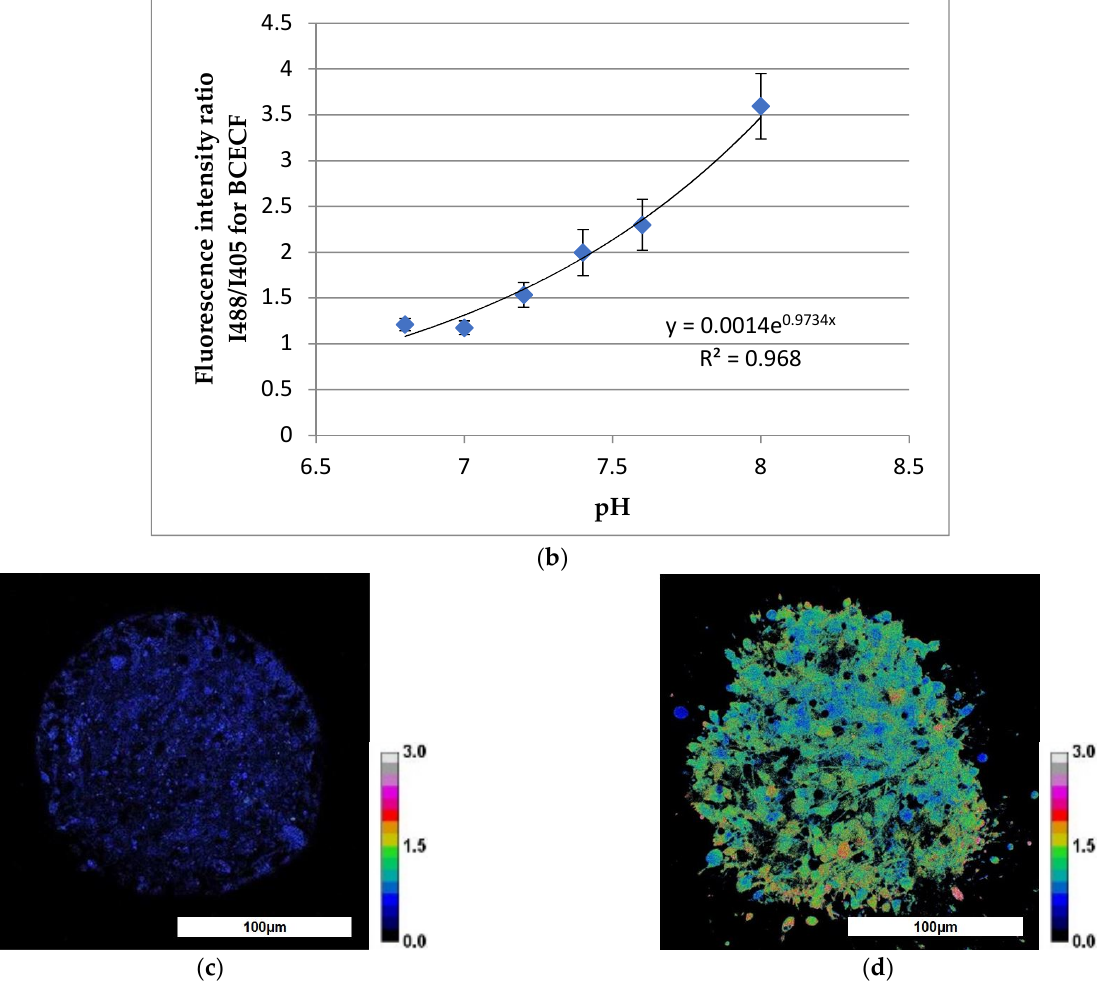
Figure 8. Analysis of the intracellular pH in TS21 and NK spheroids: ( a ) Calibration curve of the dependence of the ratio of fluorescence intensities on the pH for SypHer-2 in NK spheroids (Mean ± SD); ( b ) Calibration curve of the dependence of the ratio of fluorescence intensities on the pH for BCECF in TS21 spheroids (Mean ± SD); ( c ) Image of the ratio of the fluorescence intensity for 488 nm to 405 nm excitation in NK spheroids-SypHer-2. Excitation of SypHer-2 fluorescence at 488 and 405 nm, fluorescence detection at 500–550 nm. Image size 213 × 213 µm; ( d ) Image of the ratio of fluorescence intensity for 488 nm to 405 nm excitation in TS21 spheroids stained with BCECF. Excitation of BCECF fluorescence at 488 and 405 nm, fluorescence detection at 500–550 nm. Scale bar: 100 µm.